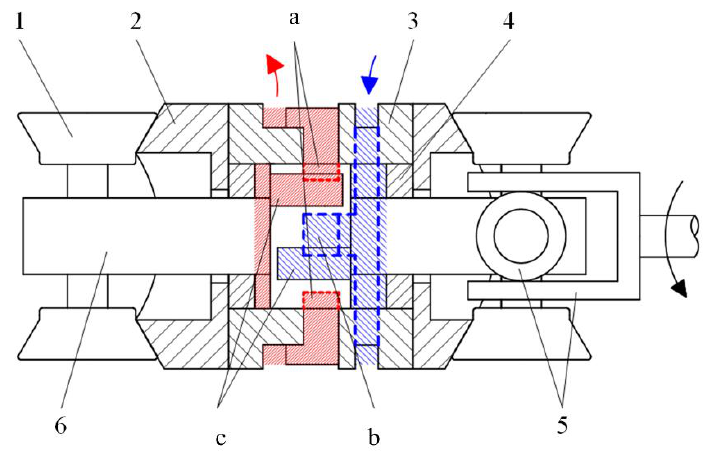
Figure 1. Schematic of a two-dimensional (2D) piston mechanism [10]: ( 1 ) Cone roller; ( 2 ) Cam guiding rail; ( 3 ) Cylinder; ( 4 ) Limit block; ( 5 ) Transmission shaft; ( 6 ) 2D piston; ( a ) Discharge windows; ( b ) Intake windows; ( c ) Distributing slots.